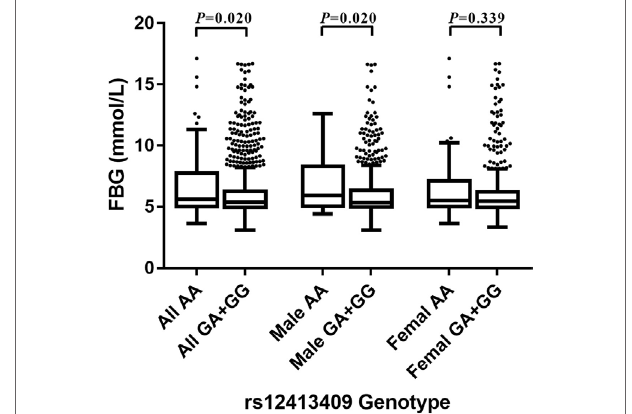
FigUre 1 | Box-whisker plot of fasting blood glucose (FBG) levels in the non-oral hypoglycemic agents and/or insulin takers study subgroup ( N = 1,459), stratified by rs12413409 genotype and gender. The plot shows the median within the interquartile range box, with whiskers extending to the 5th and 95th percentiles; data points beyond the whiskers are displayed as dots. Groups were compared by the Mann–Whitney nonparametric test.